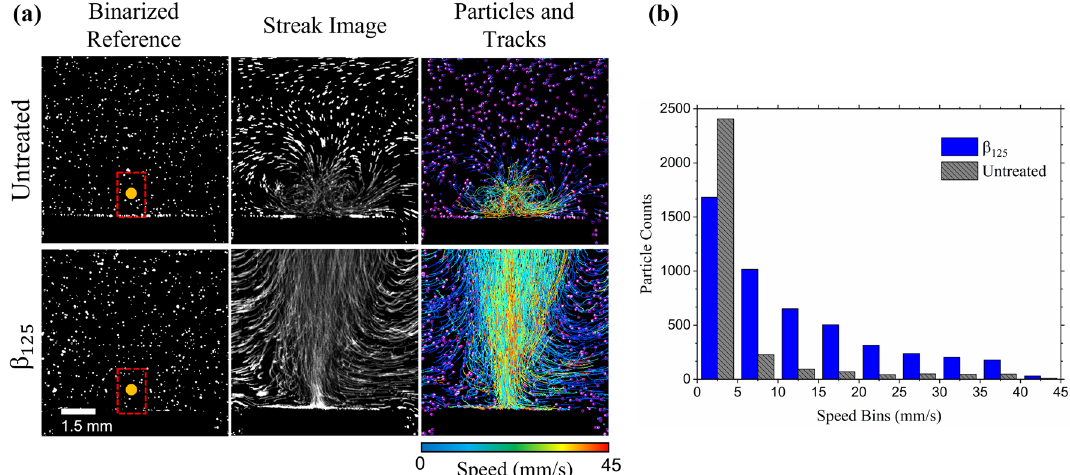
Figure 11. ( a ) Pathlines of seeded fluorescent particles to show dynamics following cavitation bubble collapses near, ( b ) an untreated PDMS surface and ( b ) a β 125 microstructure